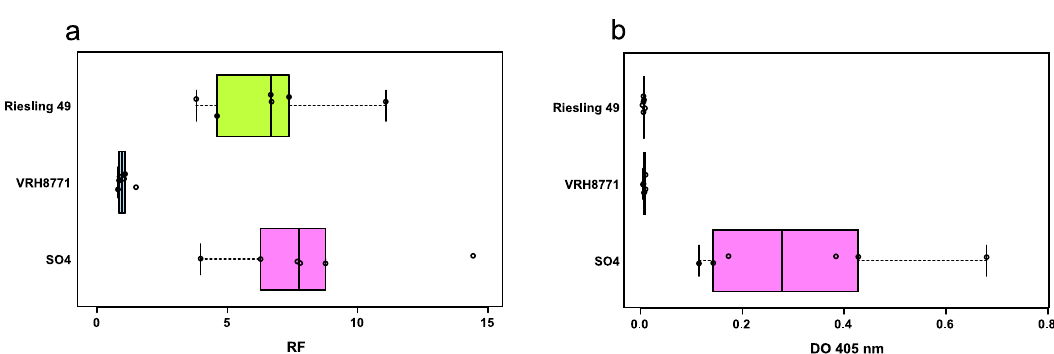
Fig. 2 Characterisation of the nature of the Riesling resistance to grapevine fanleaf disease. Evaluation of nematode multiplication ( a ) and DAS-ELISA ( b ) performed on roots of three grapevine genotypes. The centre lines show the medians, the box limits indicate the 25th and 75th percentiles, the whiskers extend to 1.5 times the interquartile range from the 25th and 75th percentiles, and the data points are plotted as open circles. n = 6 sample points.